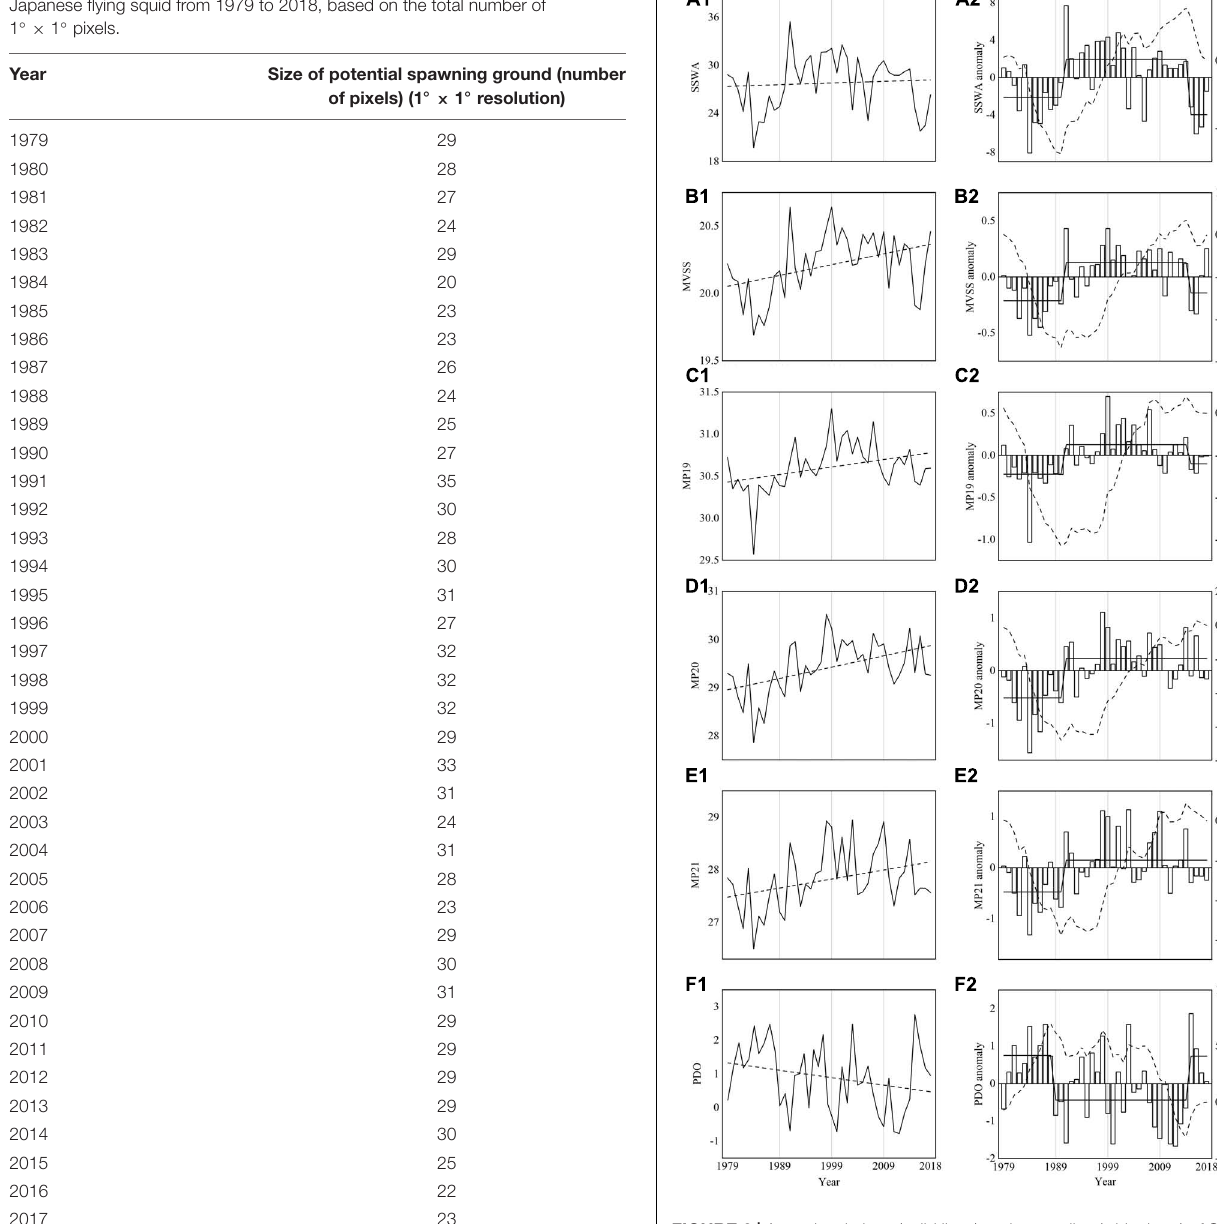
FIGURE 6 | Annual variations (solid lines) and anomalies (white bars) of SSWA (A1,A2) , MVSS (B1,B2) , MP19 (C1,C2) , MP20 (D1,D2) , MP21 (E1,E2) , and PDO (F1,F2) from 1979 to 2018. The black dash lines in A1 to E1 represent linear trends. Dash and solid lines in panels (A2–F2) represent cumulative sum (CuSum) of anomalies and regime shifts detected by SRSD, respectively. SSWA, suitability SST-weighted area of potential spawning ground; MVSS, mean values (January–April) of suitable SST; MP19, the meridional position of 19 ◦ C SST isoline; MP20, the meridional position of 20 ◦ C SST isoline; MP21, the meridional position of 21 ◦ C SST isoline; and PDO, the winter-averaged Pacific Decadal